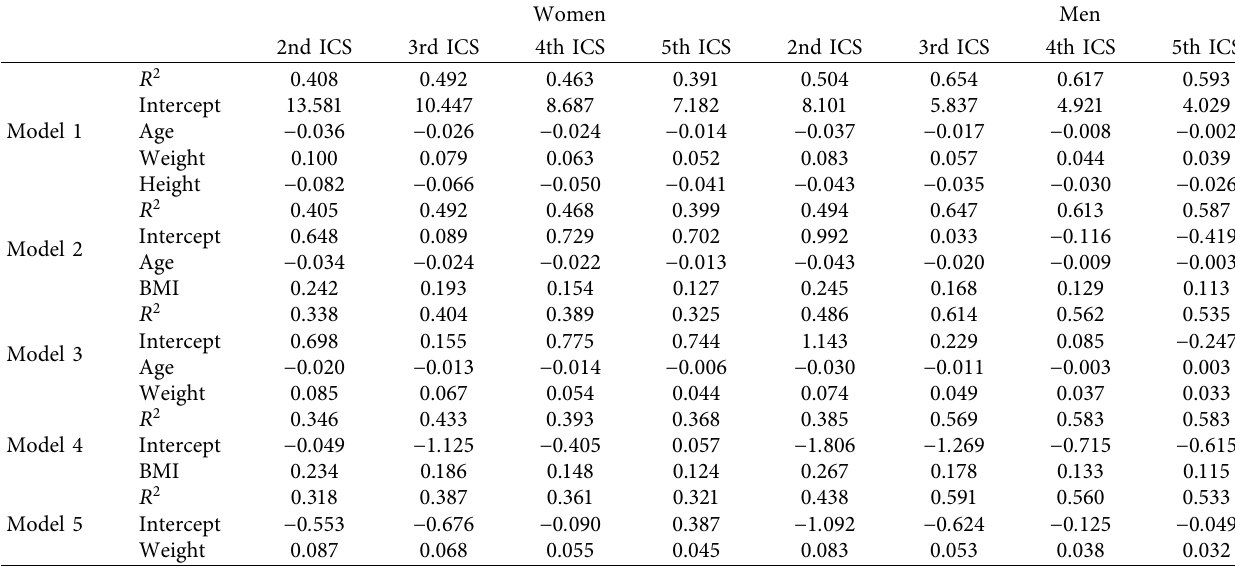
Table 4: Bootstrapping coefficients of five proposed models.